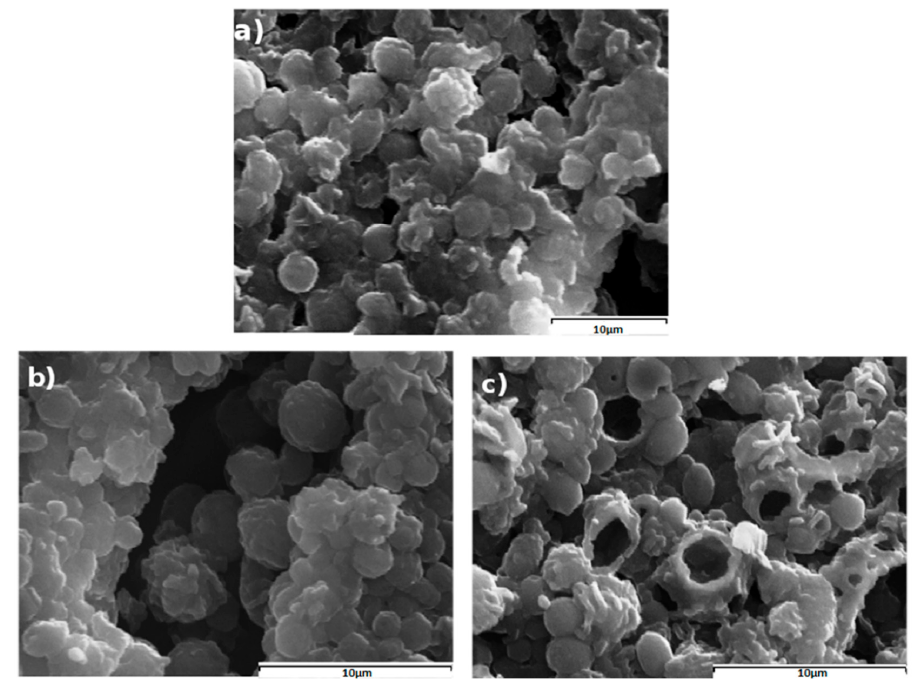
Figure 9. SEM images of ( a ) NLX-loaded/TEHA-b-PCL; ( b ) NLX-loaded TEHA-b-mPEG; ( c ) NLX-loaded/TEHA-b-PEG-b-TEHA microspheres after 50 days of